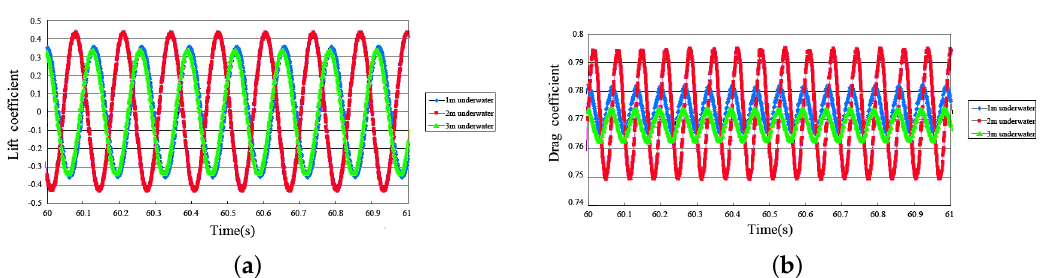
Figure 7. Contrast curves of TTR lift and drag coefficients at different underwater depths: ( a ) contrast curve of TTR lift coefficient at different water depths; ( b ) contrast curve of TTR drag coefficient at different water depths.